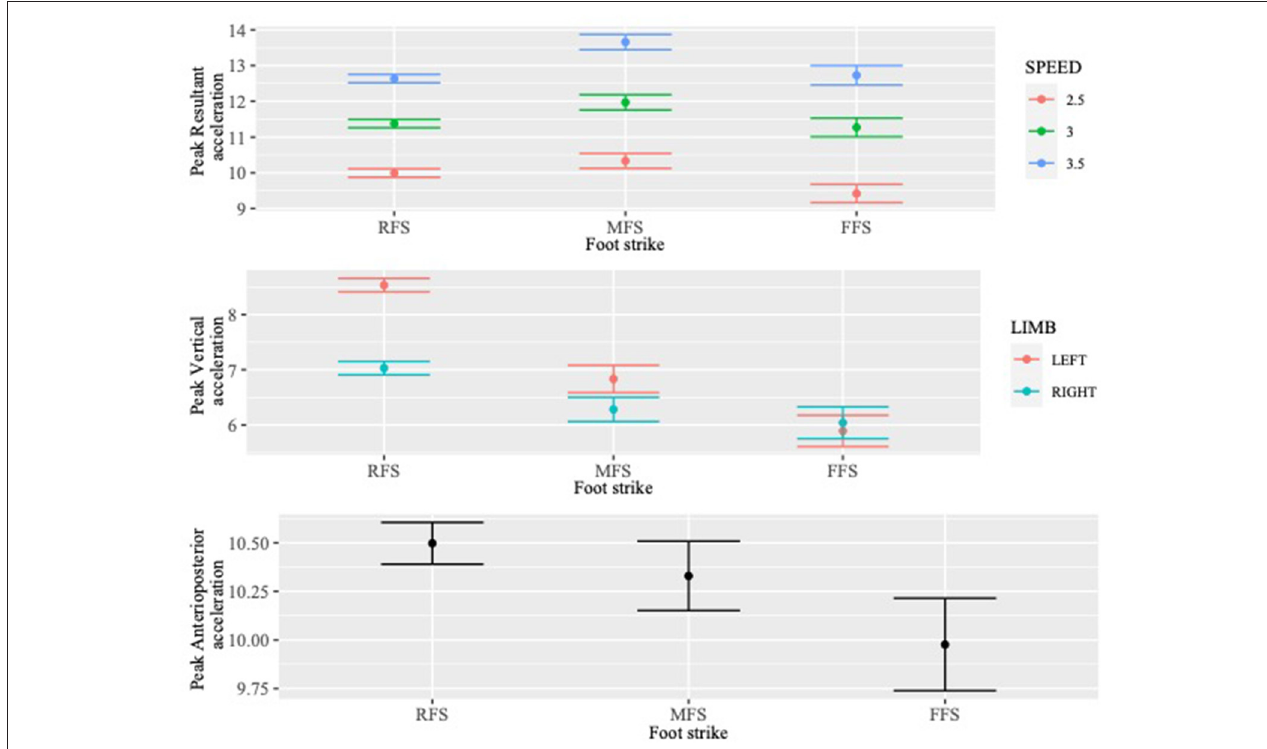
FIGURE 3 | The adjusted relationships between the acceleration outcomes (peak resultant, vertical, and anteroposterior) and foot strike pattern, when controlling for running speed, limb, and interactions as indicated by models (running speed for resultant acceleration and limb for vertical acceleration).